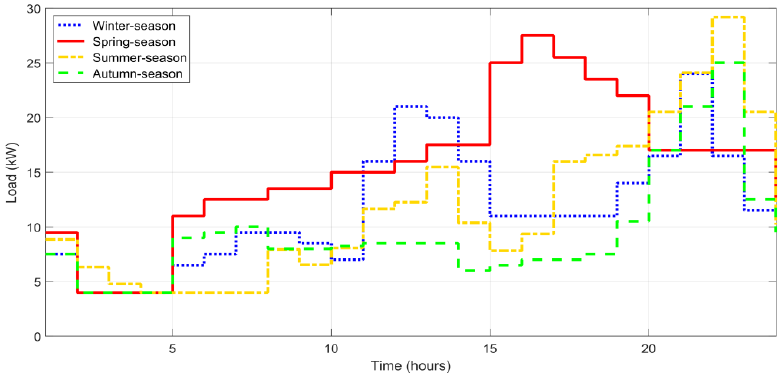
Figure 7. Load profile in the winter, spring, summer, and autumn seasons.